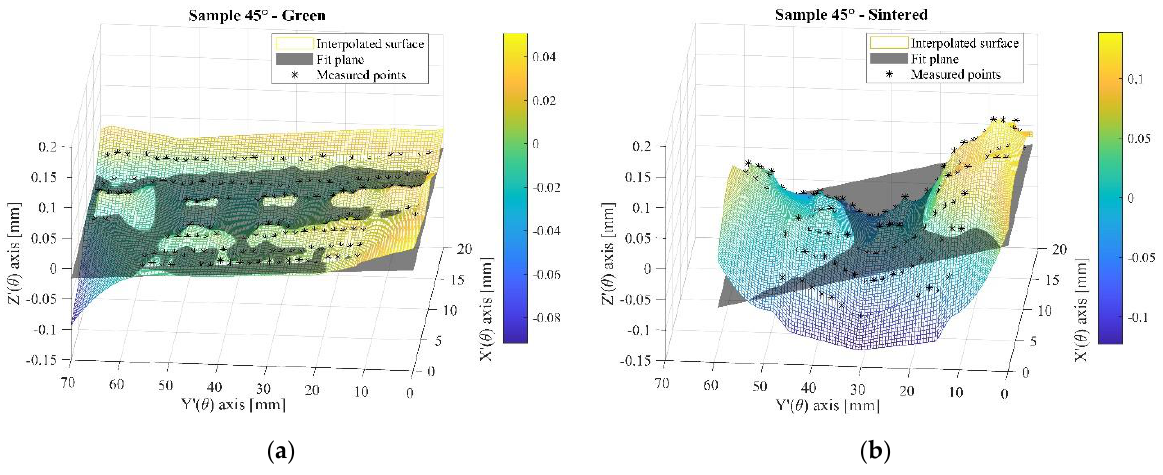
Figure 15. Sample 45° ( a ) points measured at the green state and reconstruction of the plane; ( b ) points measured at the sintered state and reconstruction of the plane.